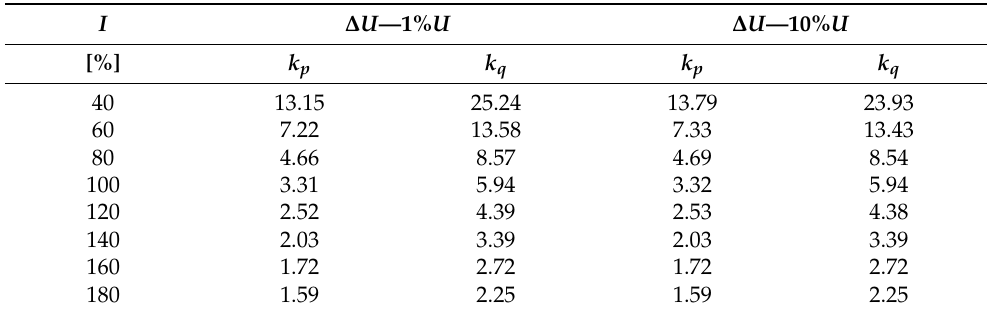
Table 1. Summary of the inclination coefficients of the power–voltage characteristics for two different ranges of voltage